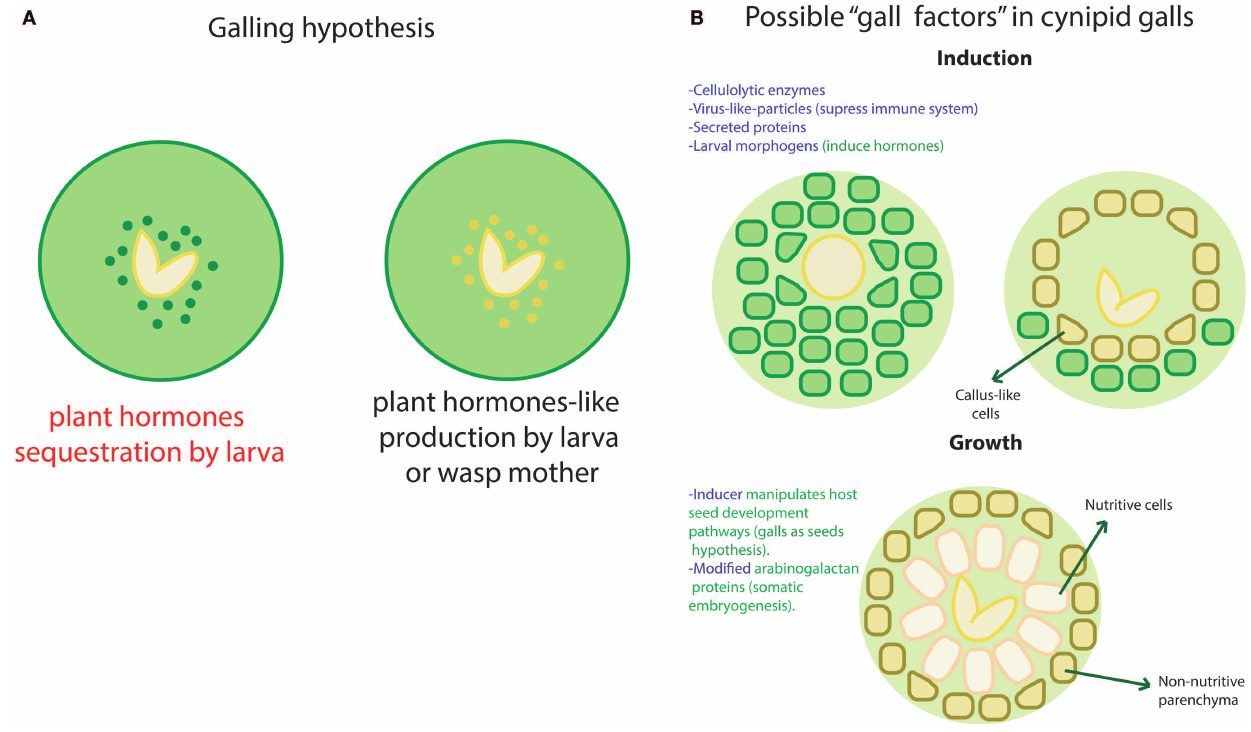
trick plant’s network as in the right case. (B) There are multiple factors in both wasp (blue font) and plants (green font) that could be involved in the induction and/or preservation of galls without the need to interfere directly with the hormones. Here we show some of such hypotetical factors in two phases of gall development: induction and growth. Changes in the plant cells and structures are indicated with